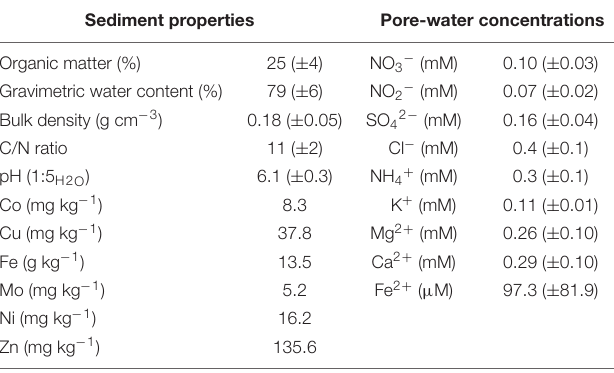
TABLE 1 | Initial properties of sediment and